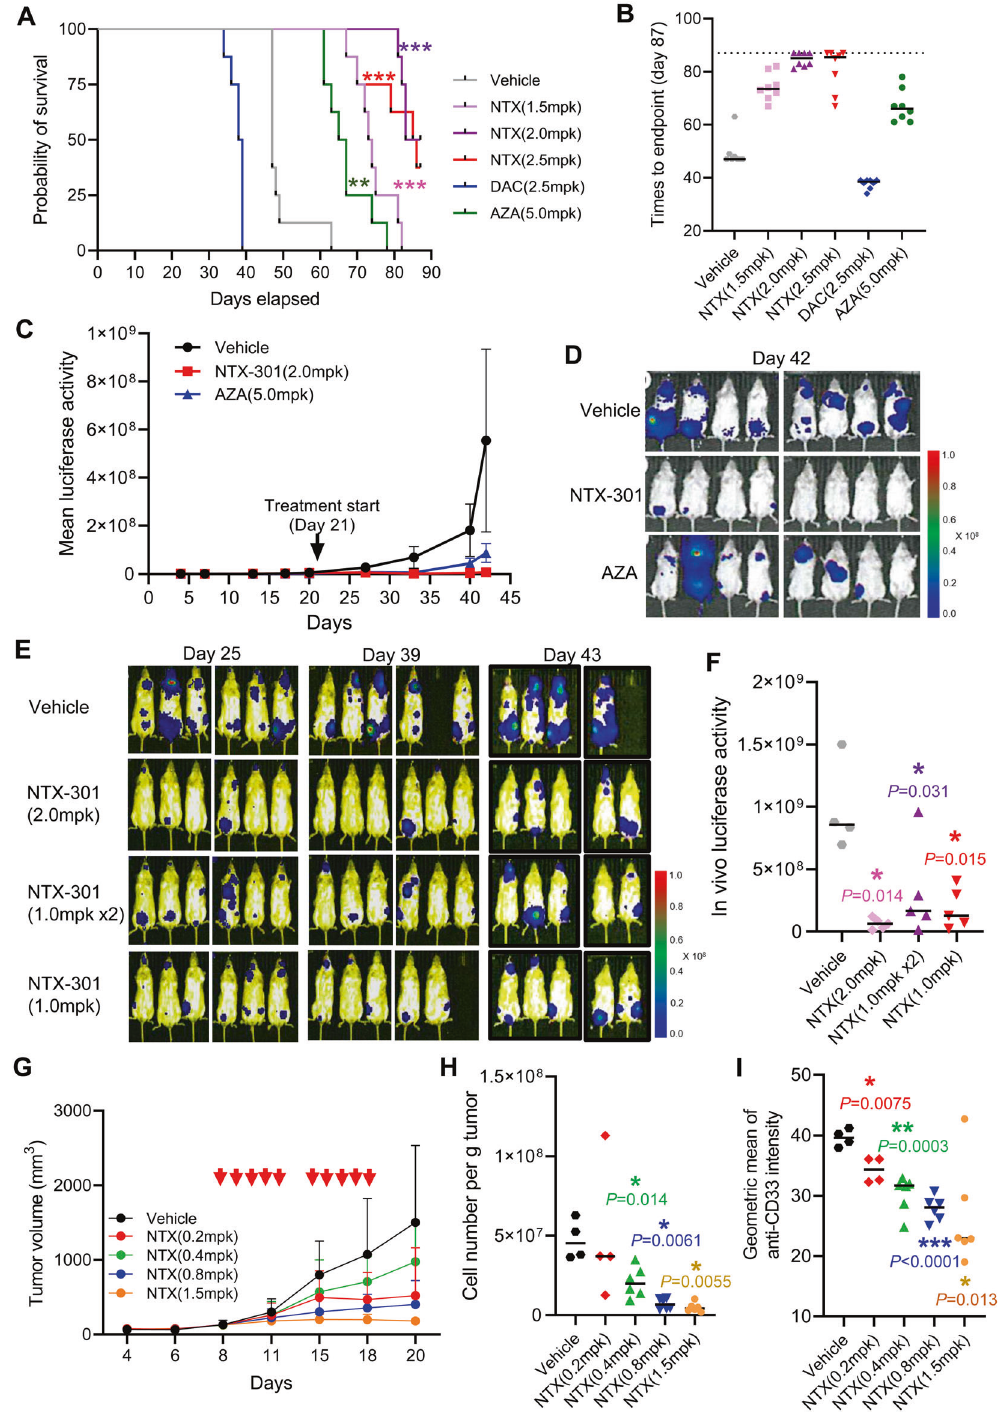
Fig. 1 Preclinical models of AML demonstrated the improved therapeutic index of NTX-301. A , B A Kaplan – Meier plot of the survival probability ( A ) and a plot showing times to endpoint (moribund or the last day of study) ( B ) of female NOD/SCID mice bearing MV4-11 tumors ( n = 8 per group, six groups) upon treatment with NTX-301 [(1.5, 2.0, or 2.5 mg/kg) (p.o.)], DAC [(2.5 mg/kg) (i.p.)], or AZA [5.0 mg/kg (i.p.)]. C , D Tumor growth measured by the quanti fi cation of bioluminescence emission (photons/sec) ( C ) and bioluminescence images on day 42 ( D ) in female NOD/SCID mice bearing MV4-11 tumors ( n = 8 per group, three groups) upon treatment with NTX-301 [(2.0 mg/kg) (p.o.)] or AZA [(5.0 mg/kg) (i.p.)]. E , F Bioluminescence images ( E ) and quanti fi cation of bioluminescence emission (photons/sec) ( F ) of female NOD/SCID mice ( n = 6 per group, four groups) bearing luciferase-labeled MV4-11 tumors upon treatment with NTX-301 [(daily at 1.0 or 2.0 mg/kg) or 2x daily at 1.0 mg/kg (p.o.)]. G – I Tumor growth ( G ), cell number per gram tumor ( H ), and anti-CD33 staining intensity ( I ) of female NMRI nude mice bearing subcutaneous MOLM-13 tumors ( n = 6 per group, fi ve groups) upon NTX-301 treatment [(0.2, 0.4, 0.8, or 1.5 mg/kg) (i.p.)]. In G , the red arrows denote the time points of NTX-301 treatment. AZA azacitidine, DAC decitabine, NTX NTX-301; mpk mg/kg, p.o. oral administration, i.p. intraperitoneal administration. P -values (vs. vehicle) are speci fi ed and marked as follows: * p < 0.05; ** p < 0.001; *** p <